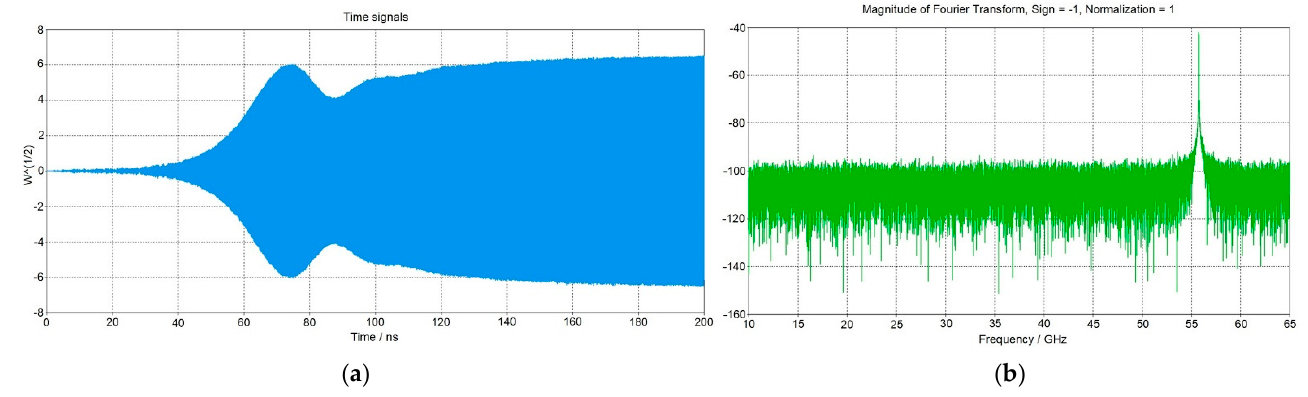
Figure 18. Results of the 3D CST simulations of a V-band gyrotron with a cavity and with a selective cavity with an azimuthal groove: ( a ) time dependence of the amplitude of the output signal demonstrating the establishment of the stationary regime of generation (the square of the amplitude corresponds to the instantaneous power in watts); ( b ) frequency spectrum of the field inside the cavity—only the third harmonic of the cyclotron frequency was excited.